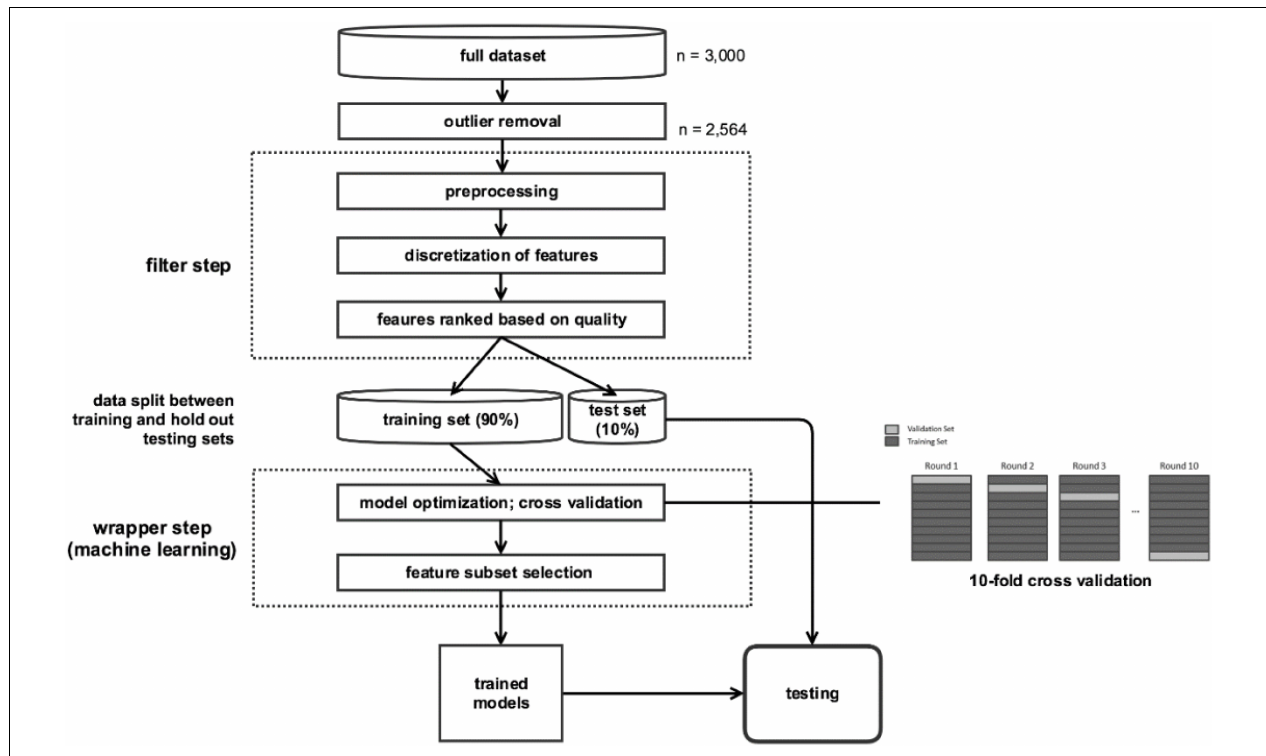
FIGURE 1 | Flowchart of analytical